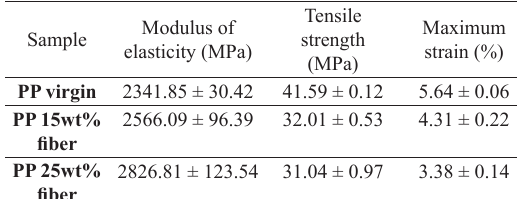
Figure 8. Tensile test for composite PP 25wt%